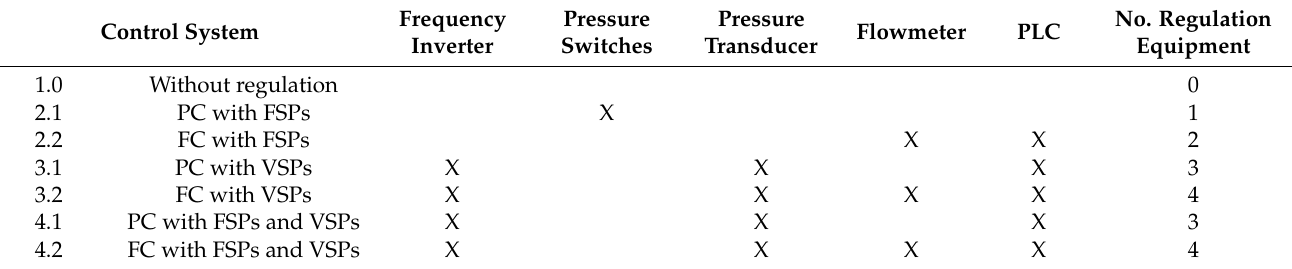
Table 1. Require equipment or device for different control